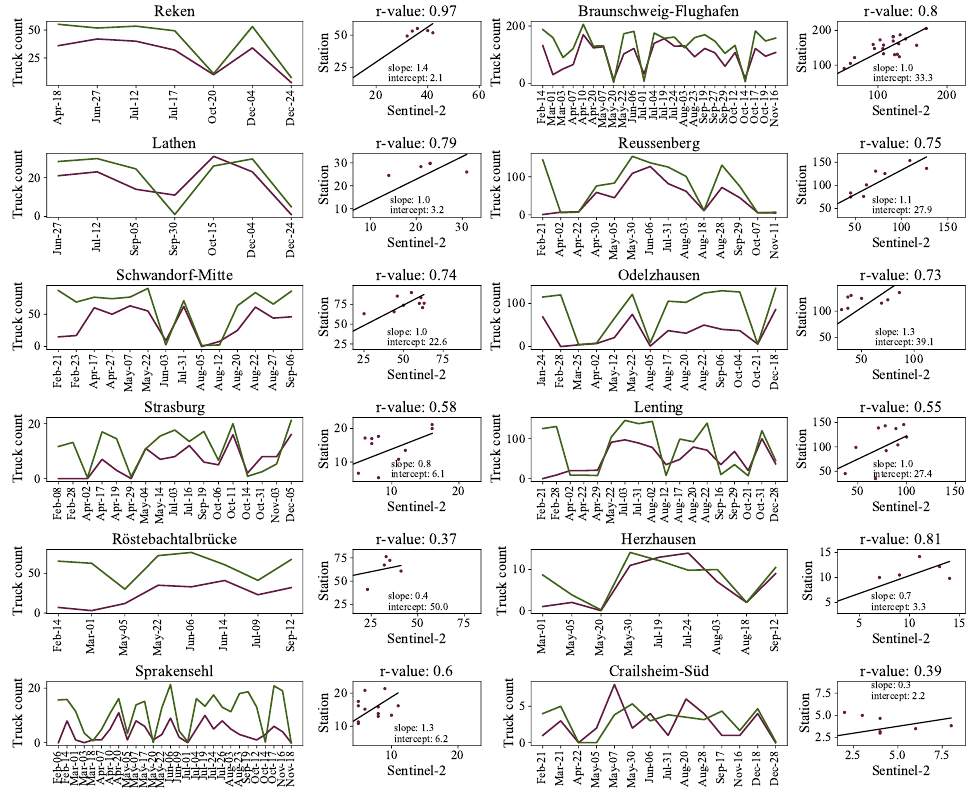
Figure 14. Station and Sentinel-2 truck count series, scatter and regression at selected validation stations in 2018 (green = station, red =